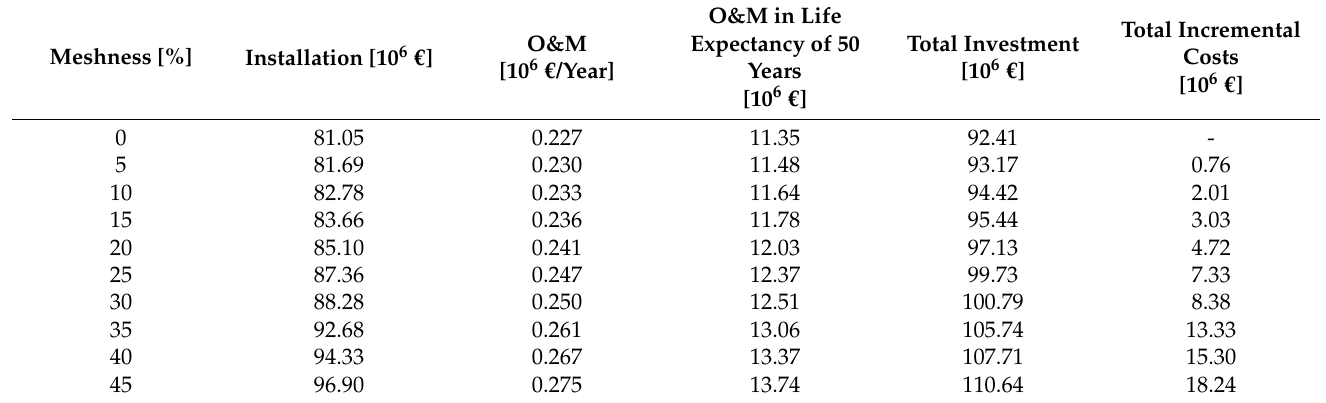
Table 2. Costs of increasing Meshness in the UDN (Present value in euros 2019).